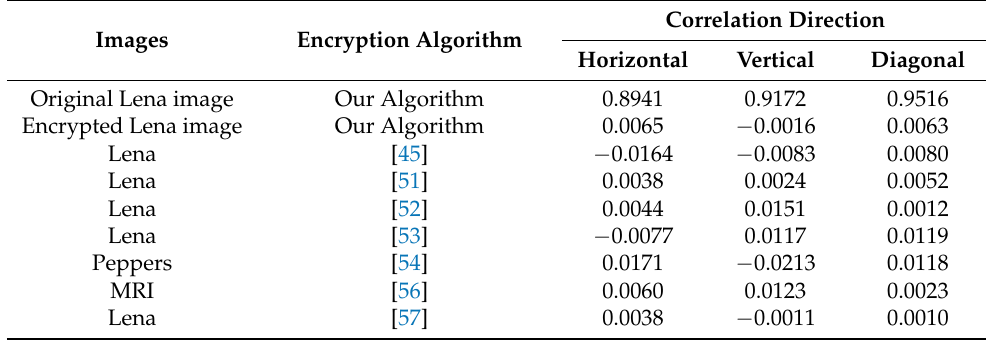
Table 2. The comparison of the correlation coefficient(s) ( CC ) between our proposed image encryption scheme with other image encryption schemes.